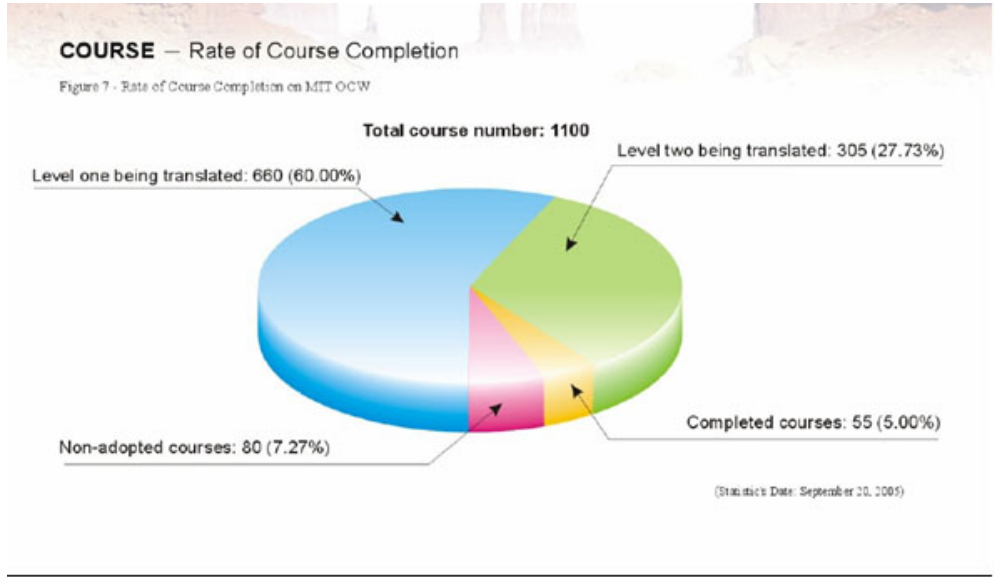
Figure 3. OOPS course adoption and completion of MIT OCW